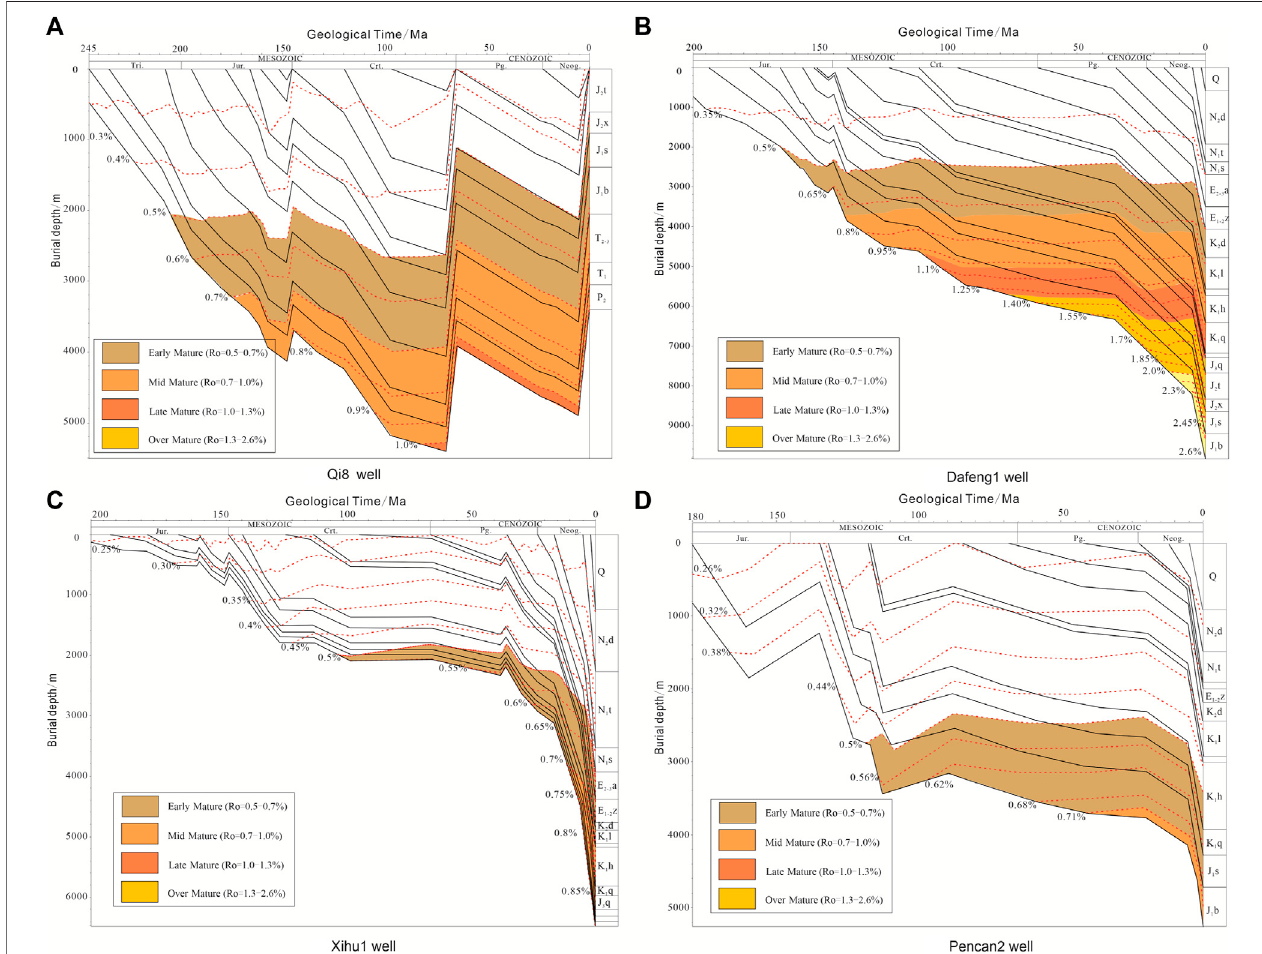
FIGURE 9 | Burial and thermal history of different regions in the South Junggar foreland basin. (A) Burial and thermal history of Qi8 well in the southern belt of anticlines showing late-stage uplift and erosion. (B) Burial and thermal history of Dafeng1 well in the northern belt of anticlines showing continued and stable burial. (C) Burial and thermal historyof Xihu1 well in the Sikeshu depression, showing early shallow burial and late rapid burial. (D) Burial and thermal historyof Pencan 2 well in the northern slope, showing continuous slow burial.